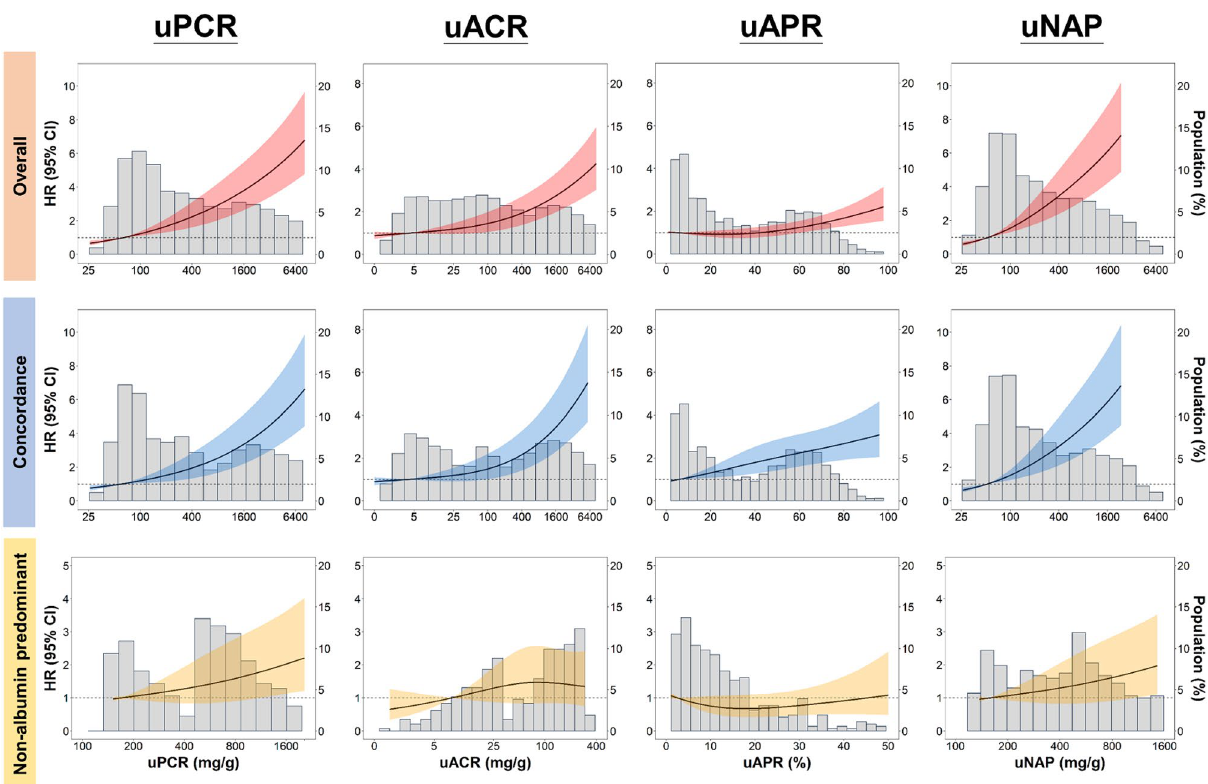
Figure 2. Hazard ratios for all-cause mortality based on uPCR, uACR, uAPR, and uNAP. Solid black lines represent aHRs based on restricted cubic splines for each urinary biomarker with knots at the 10th, 50th, and 90th percentiles. Dark-red shaded areas represent 95% CI. The reference was set at the 10th percentile of each urinary biomarker.